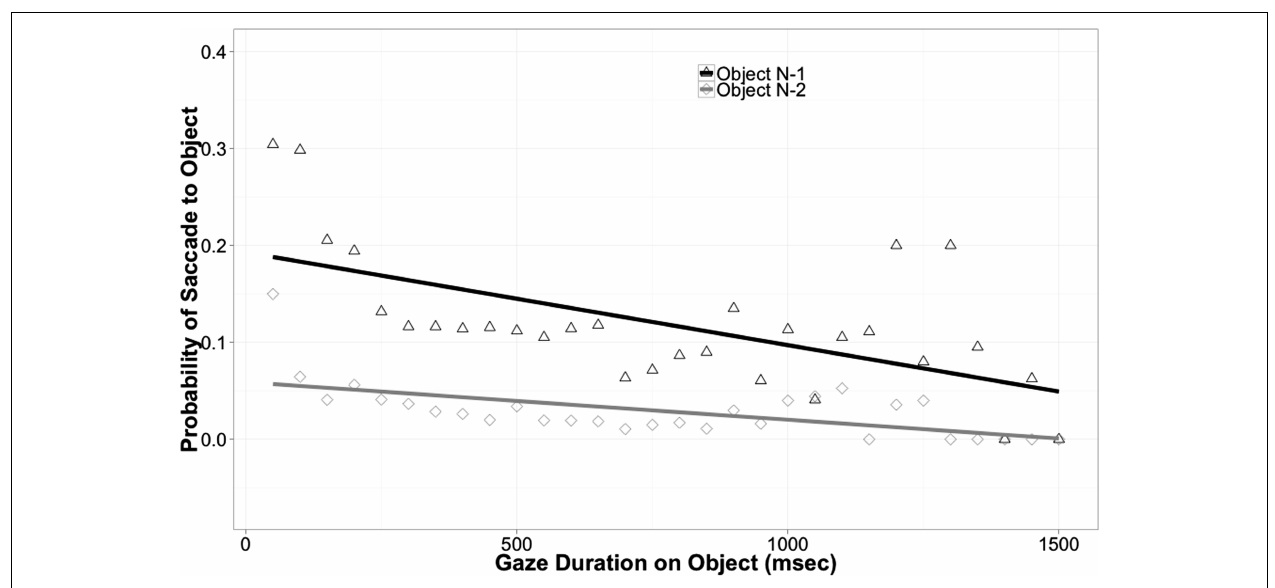
FIGURE 5 | Probability of saccade back to an object as a function of object and of previous gaze duration on that object (i.e., how long the object was viewed before the eyes left